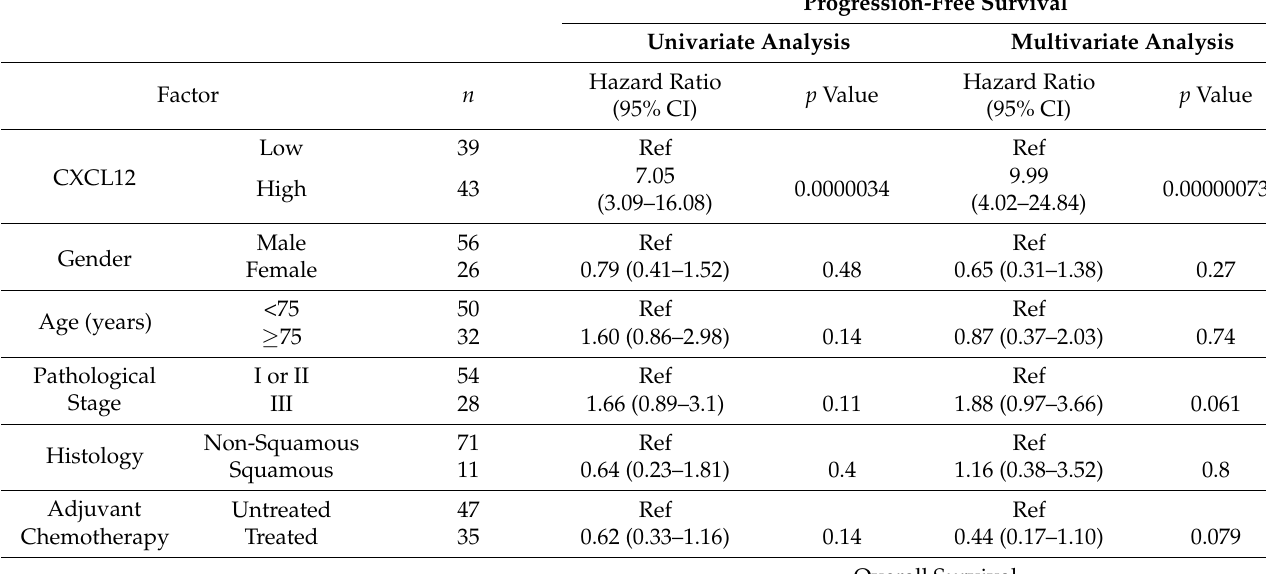
Table 2. Univariate and multivariate analysis. Progression-Free Survival Univariate Analysis Multivariate